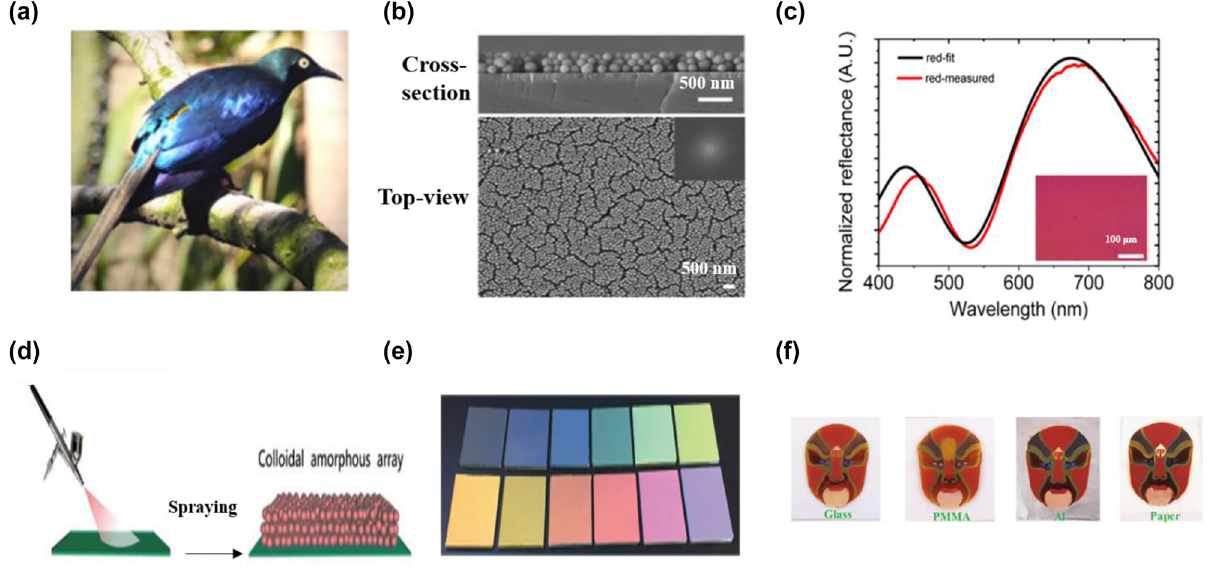
Figure 20: Self-assembly approach for fabricating multi-layer thin film based structural colors. (a) Photo of a bird. The color in its feather is produced by the self-assembled melanosomes. (b) Cross-sectional and top-view SEM images of a fabricated sample composed of synthetic melanin nanoparticle films. (c) Measured (red curve) and simulated (black curve) reflection spectra of a red-color sample under normal incidence. Inset shows the associated optical image. Modified with permission [217]. Copyright 2015, American Chemical Society. (d) Schematic of the fabrication process of PDA@SiO via the spraying-drying method. (e) Optical images of the fabricated devices. Particle sizes of the PDA@SiO 252 nm (upper panel, left to right) and 264, 273, 286, 291, 309, and 323 nm (lower panel, left to right). (f) Photos of multicolor Chinese opera